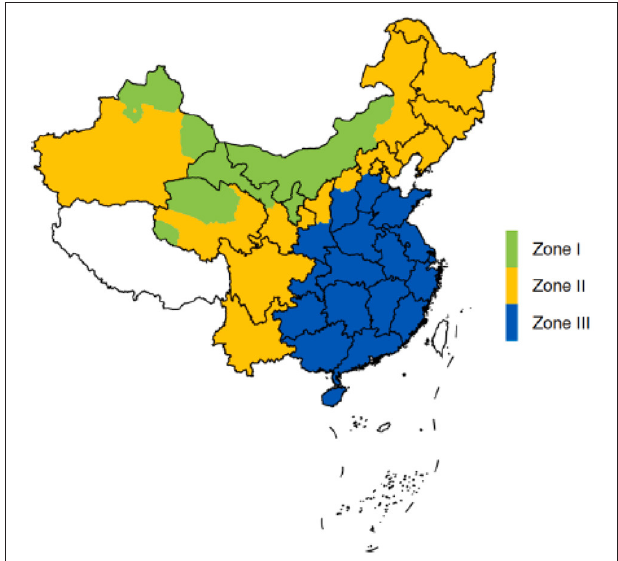
FIGURE 1 | The Chinese zonal feed-in tariff policy. Tibet was not included in the FIT policy of China (Dong et al., 2021).